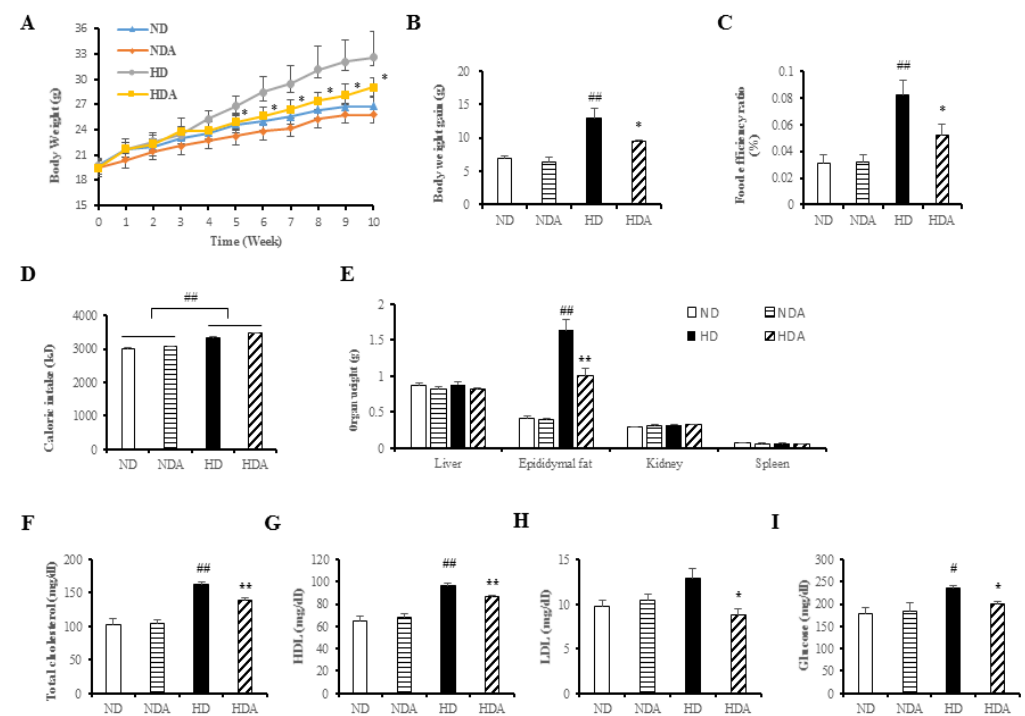
Figure 2. Effect of L. sakei ADM14 on high-fat diet-induced obese mouse model and changes in biomarkers. ( A ) Weight change of experiment mice groups for 10 weeks. ( B ) Total weight gain for each group after 10 weeks. ( C ) Food e ffi ciency ratio over 10 weeks for each group. ( D ) Total caloric intake over 10 weeks for each group. ( E ) Organ weights of mice in each group after sacrifice. ( F ) Serum total cholesterol concentration. ( G ) Serum HDL (high density lipoprotein) concentration. ( H ) Serum LDL (low density lipoprotein) concentration. ( I ) Serum fasting glucose concentration. Results are shown as mean ± SEM ( n = 5). Significant differences between HD and ND groups are indicated as # p < 0.05, ## p < 0.01. Significant differences between HD and HDA groups are indicated as * p < 0.05, ** p < 0.01.